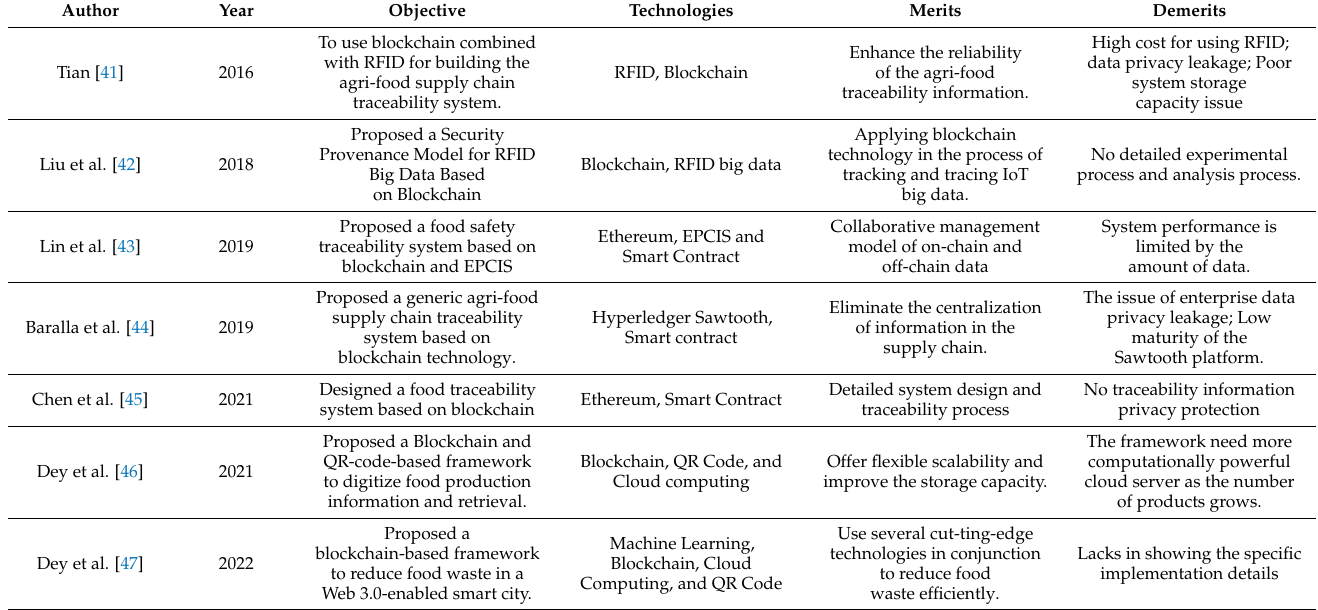
Table 1. Critical analysis of the existing works in the